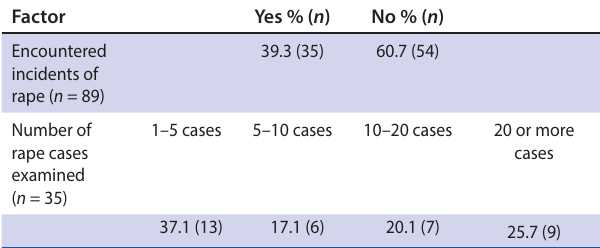
Table 1: Number of rape cases encountered by participants during community-service year